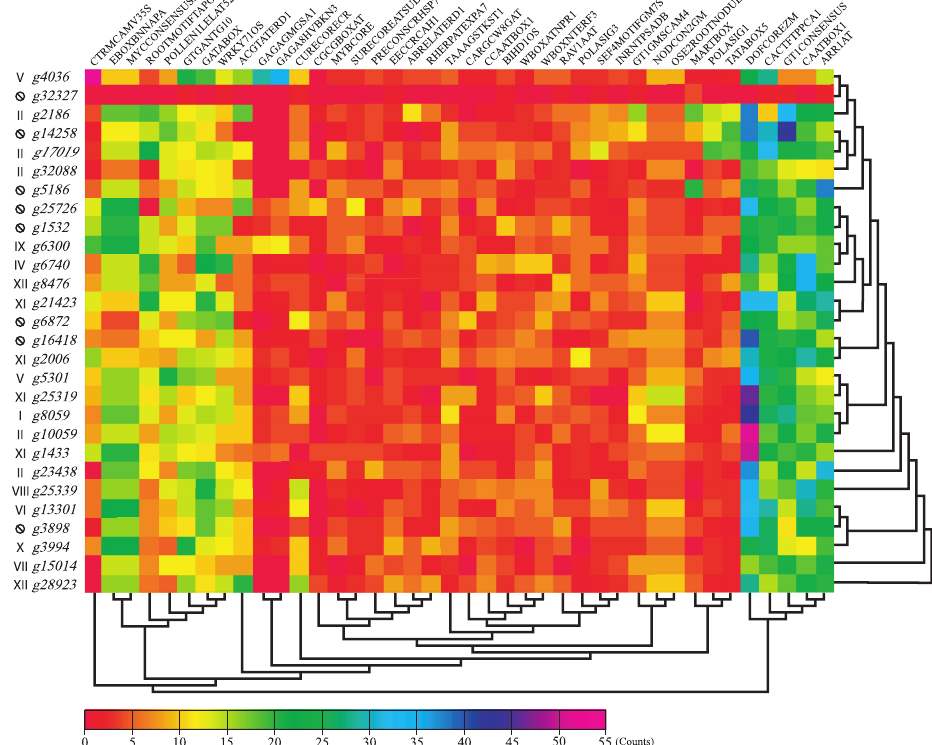
Figure 7. Motif enrichment analysis of the promoter region of Eugenia uniflora DOF genes. Rows rep- resent DOF genes while columns are motifs found. Each gene has its phylogenetic group represented on its left. Crossed-out “O”s represent ungrouped genes. Both genes and motifs were clustered using their count profiles, denoted by the cladograms on the bottom and